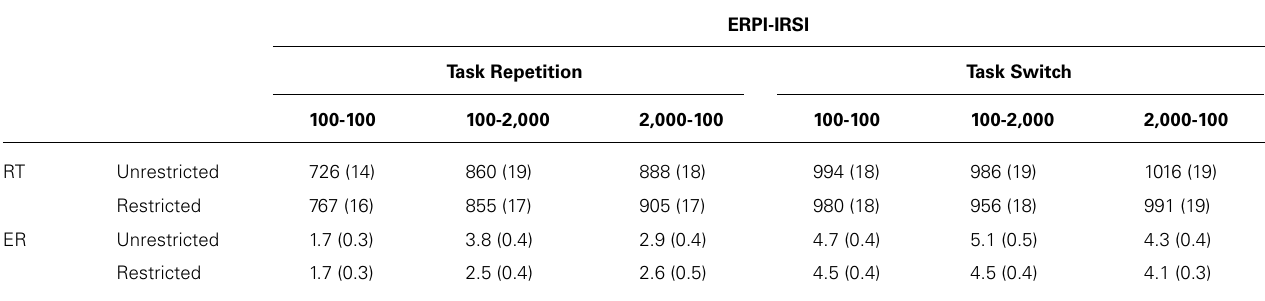
Table 1 | Mean task execution Reaction times (RTs) and error rates (ERs) as a function of ERPI-IRSI combination,TaskTransition, andTask Choice (SEM in